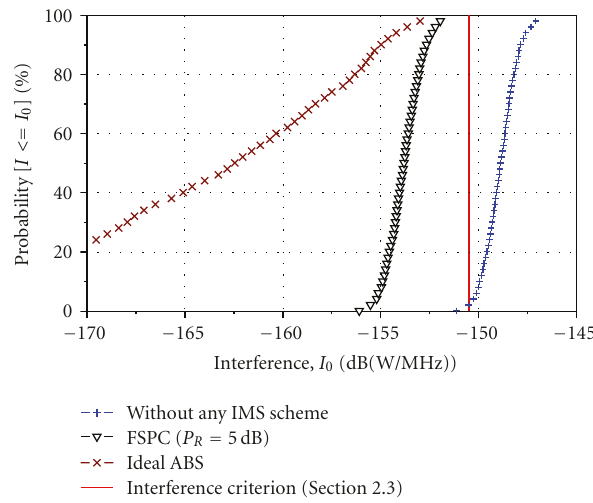
Figure 14: CDF of interference levels for ideal ABS and FSPC